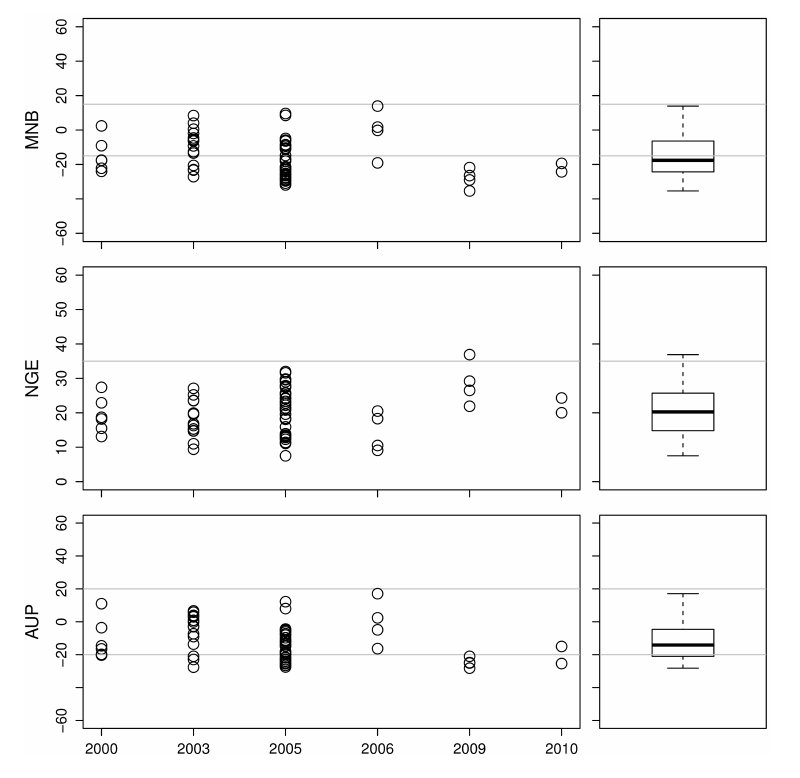
Figure 4. Statistical metrics of hourly ozone concentration in the EMEP sites in the different simulations. The right-hand panels represent all